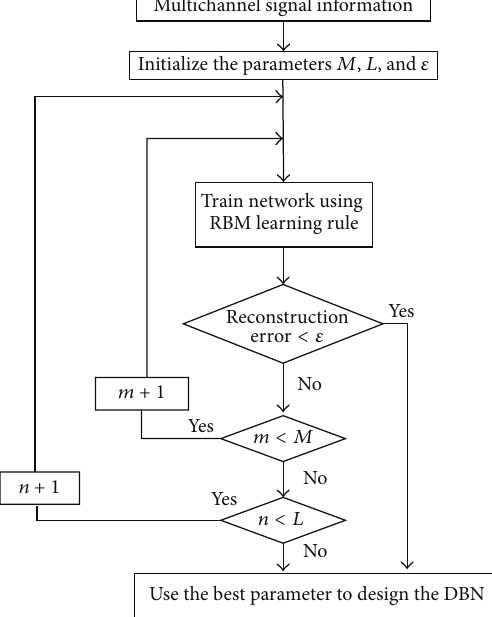
Figure 3: The flow chart of the optimization DBN in signal